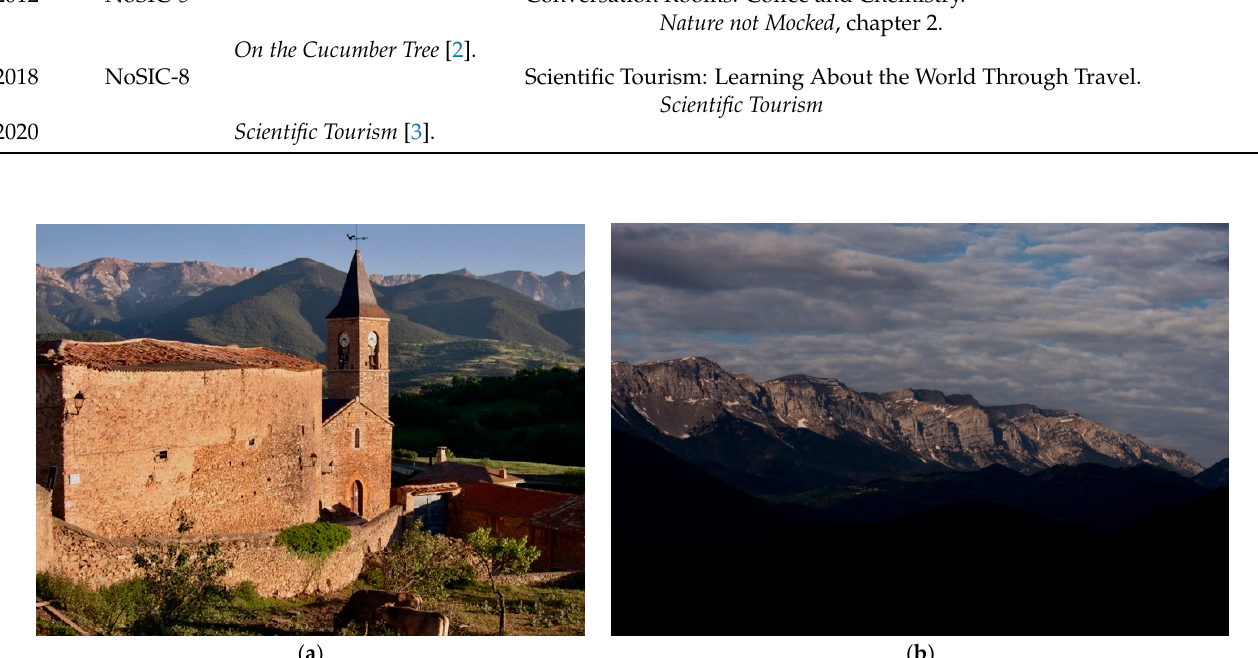
Figure 1. ( a ) The Romanesque church of Prullans, 11th–12th century, ( b ) view of the Cadí mountain range from the NoSIC conference site.